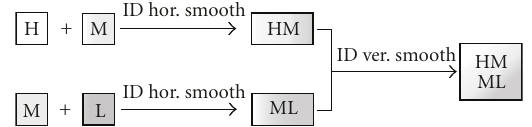
Figure 8: The proposed smoothing strategy as applied in 2D.